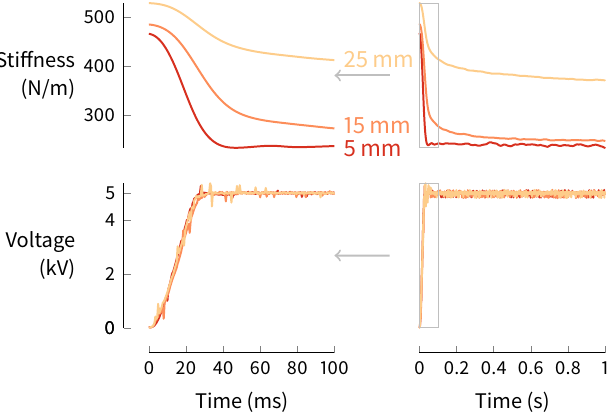
Figure 8. The DET VSA changed stiffness rapidly while charging to 5kV with only three DET modules installed and the variable-stiffness mechanism’s displacement fixed at [5, 15,